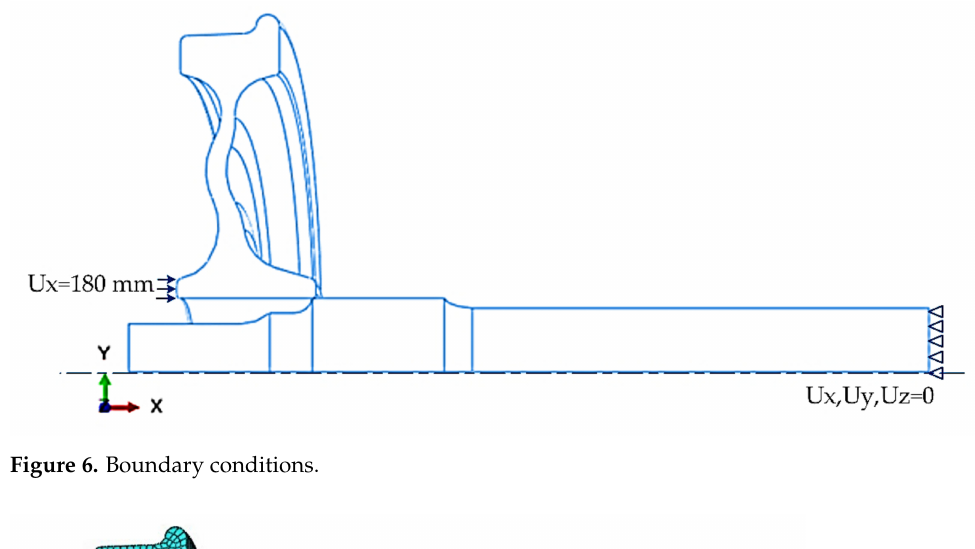
Figure 5. Dimensions of the wheelset [20].